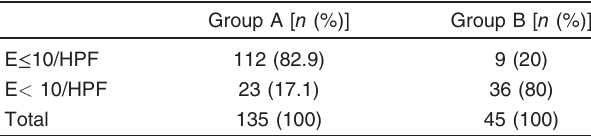
Table 5 Comparison of percentage of eosinophils in nasal smears among allergic rhinitis and control groups